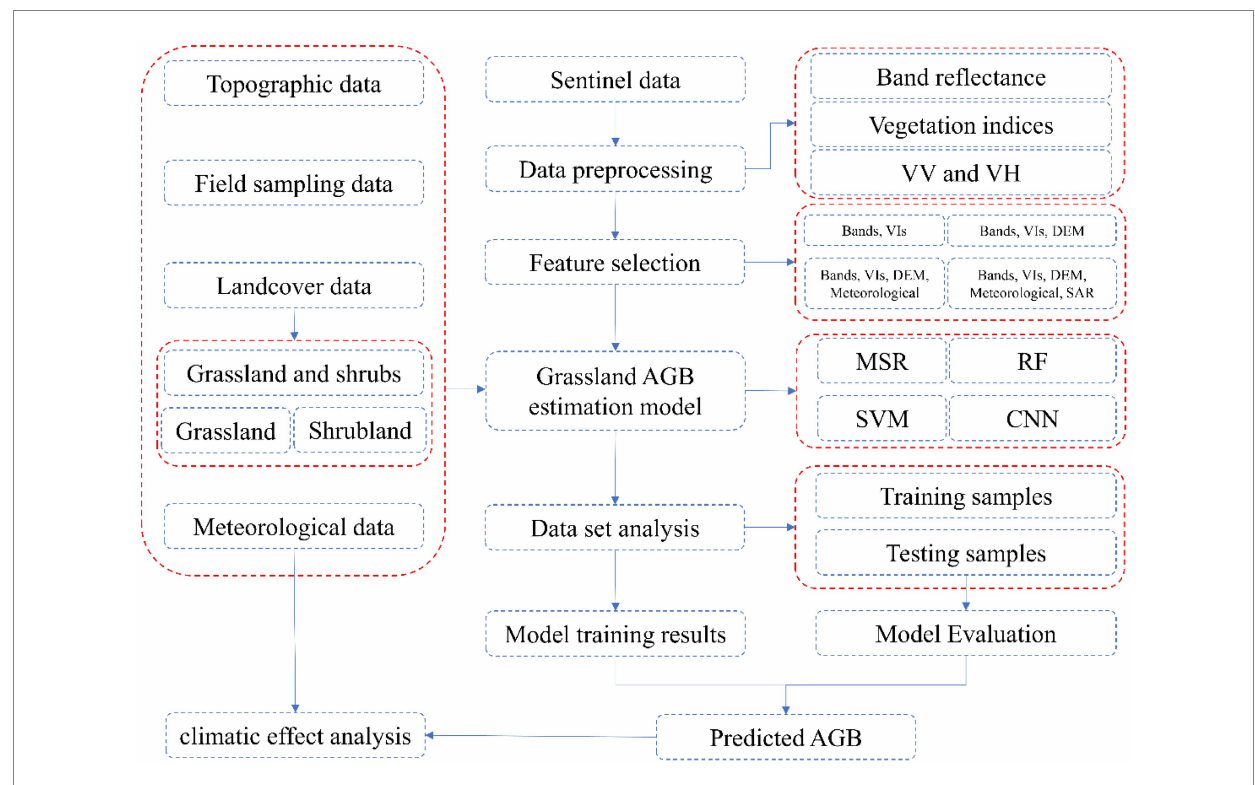
FIGURE 2 The technical flowchart of grassland AGB estimation in this